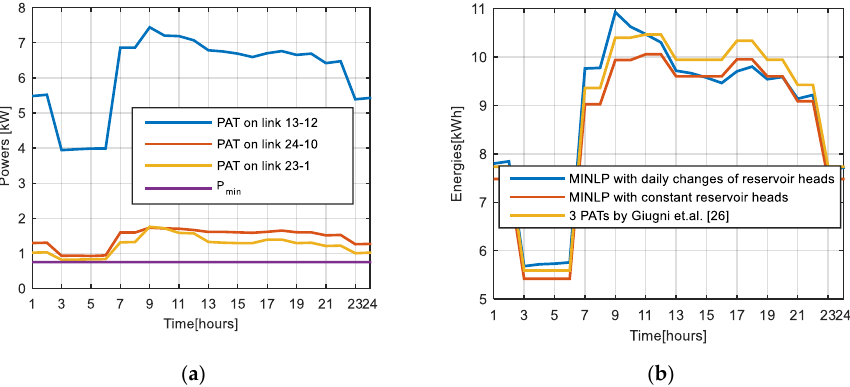
Figure 4. ( a ) Power generation profiles by varying reservoir water levels; ( b ) Comparisons by constant reservoir water levels.